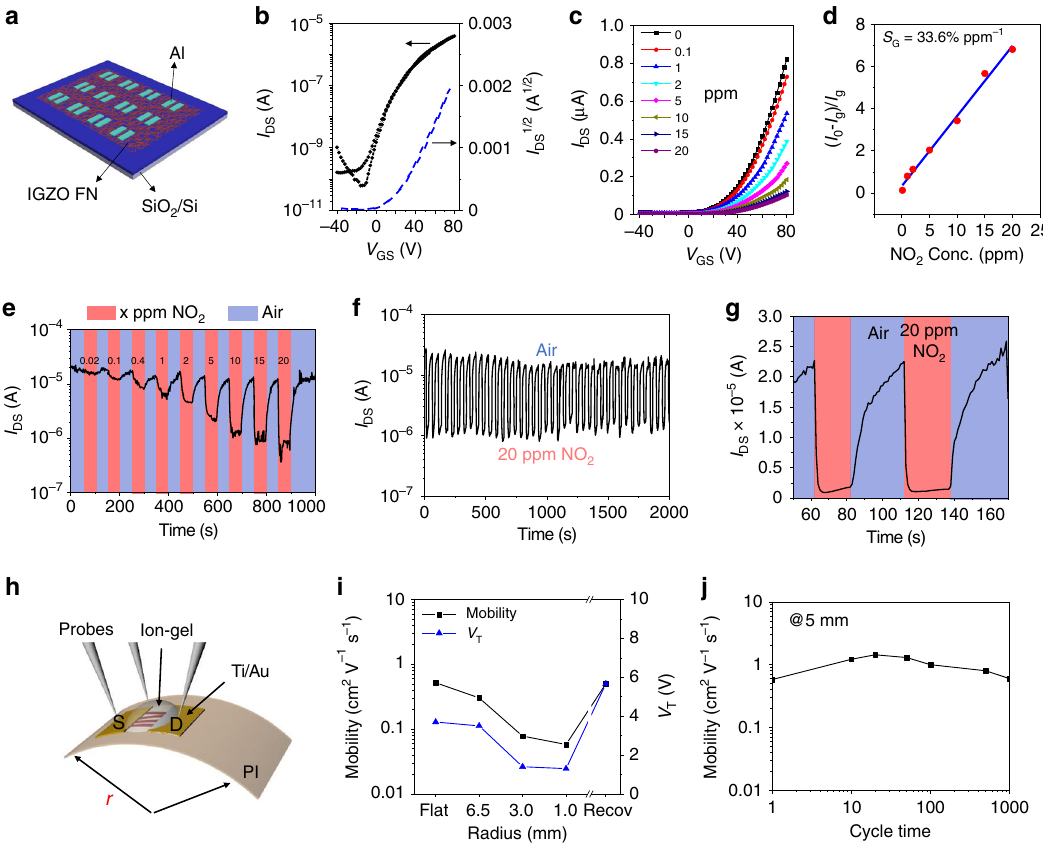
Fig. 2 IGZO FN-based TFTs and gas sensors. a Diagram of a rigid TFT array. b Typical transfer curve of an IGZO FN-based TFT. c Square-root of drain current vs. gate voltage plots of an IGZO fi ber-based TFT at the indicated NO 2 concentrations. d Relative change of saturated current as a function of NO 2 concentration. e Real-time source – drain current ( V D = V G = 50 V) response to dynamic switching between NO 2 concentrations (20 ppb – 20 ppm). f Plot of source – drain current vs. time with exposure to 20 ppm NO 2 or air. g Enlarged panel in f , showing detailed shape of sensing curves and de fi nition of response/recovery time. h Schematic representation of ion-gel gated fl exible IGZO NF-based TFT on 1.5- μ m-thick polyimide substrate. i Mobility and threshold voltage variations under the indicated bending radii. j Mobility variation over 1000 bending cycles at a radius of 5